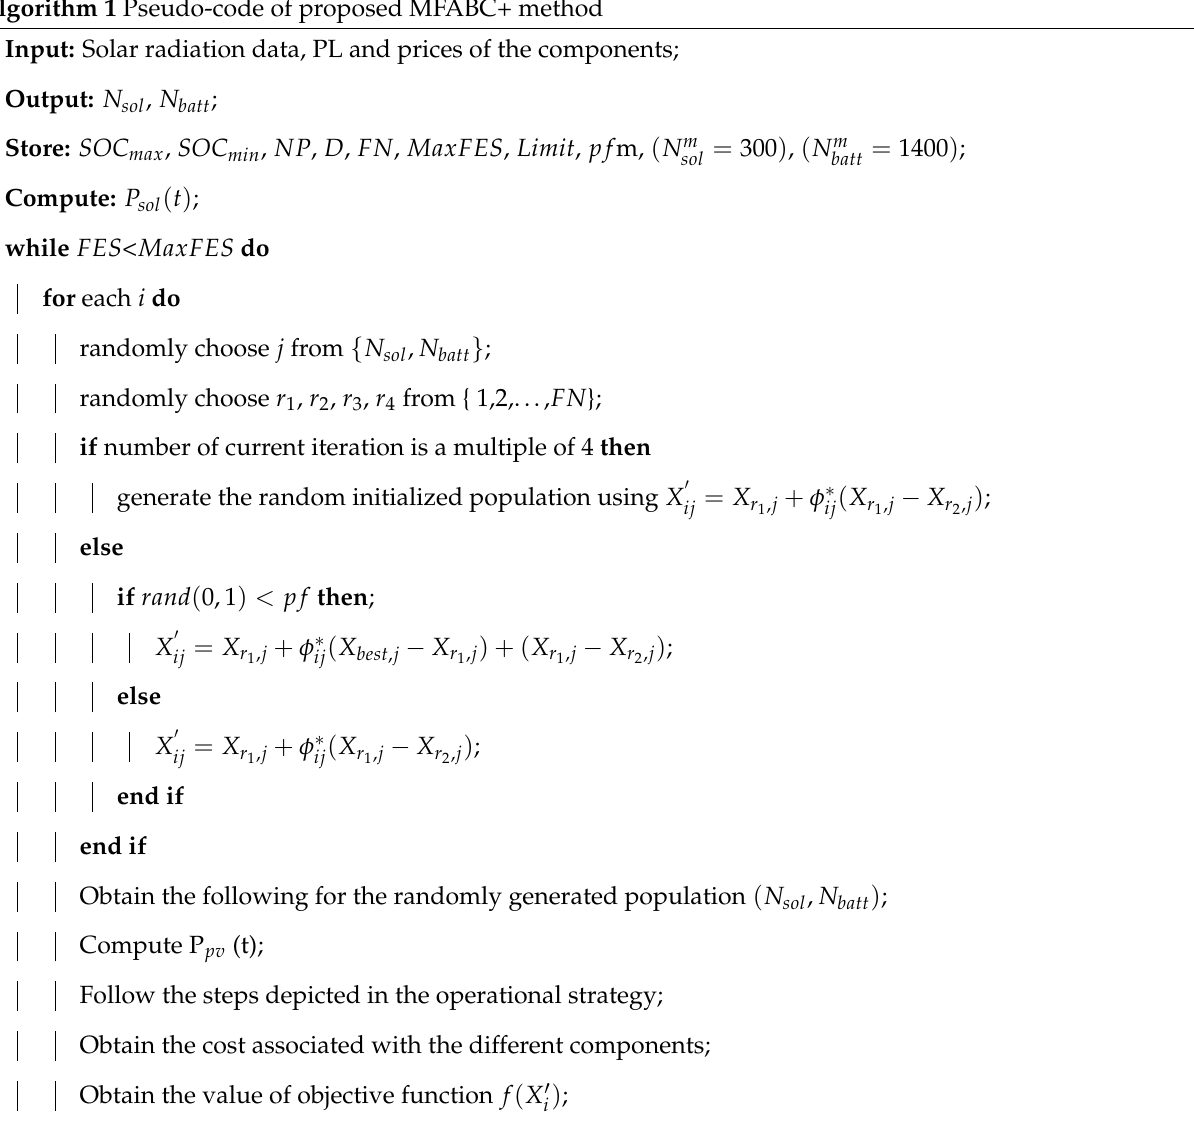
Algorithm 1 Pseudo-code of proposed MFABC+